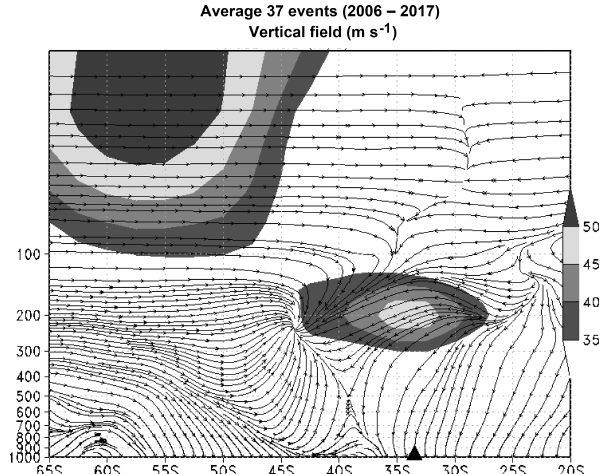
Figure 6. Mean field for the 37 AOH side-effect events in the anal- ysis period with the jet at 250hPa (shaded) and Omega at 500hPa (Omega positive solid lines, Omega negative dotted lines).